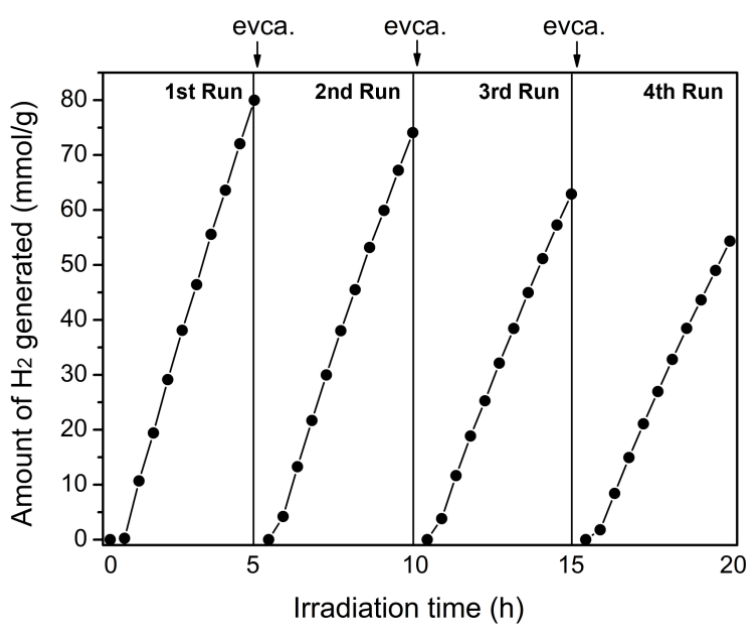
Figure 8. Stability of Pt-PdS/CdS(HZ) for photocatalytic H 2 production over Pt-PdS/CdS(HZ) under visible-light irradiation.